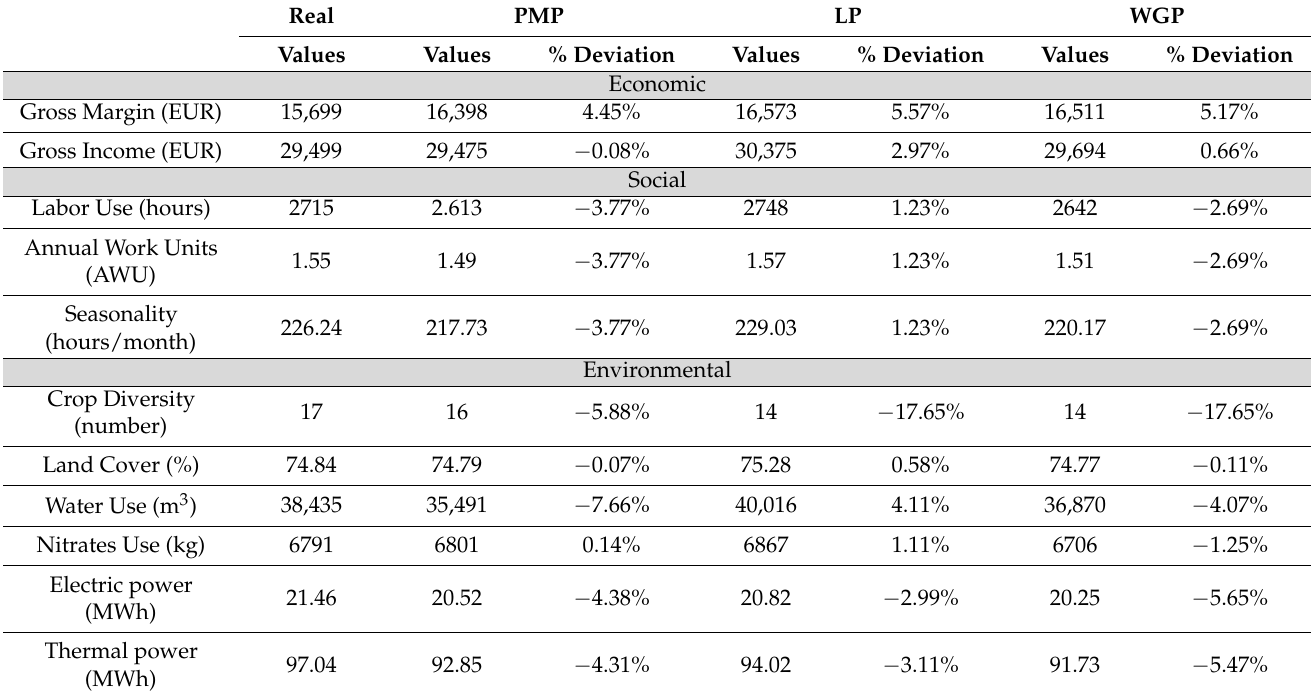
Table 5. Comparison of mathematical programming models for the sustainability indicators. Source: Our